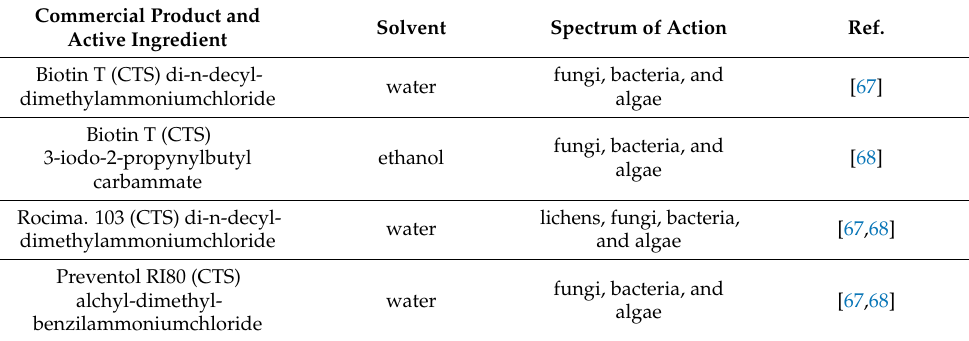
Table 2. List of most common biocides